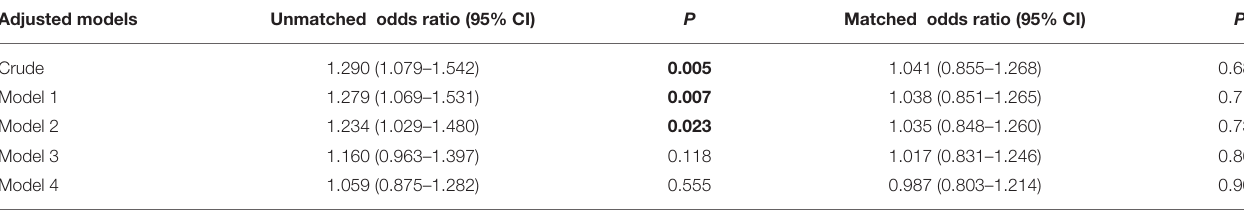
TABLE 2 | LOCM for CI-AKI on multivariable logistic regression analysis in the unmatched and matched cohorts. Adjusted models